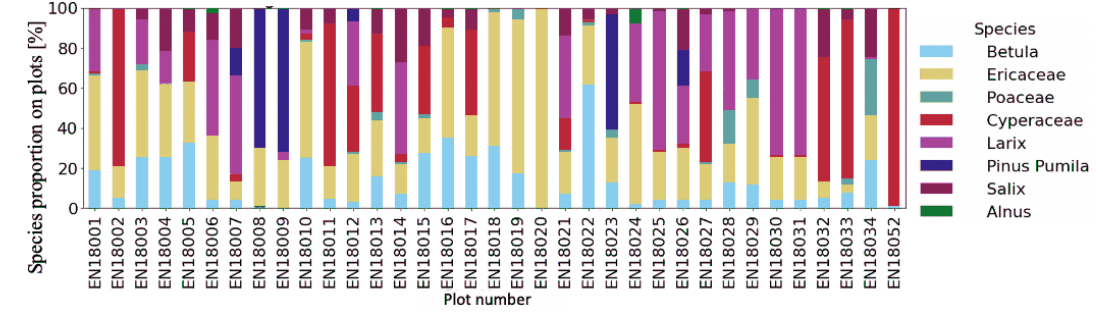
Figure A2. Percentage vegetation cover per plot in Chukotka for all recorded vegetation in the plots.